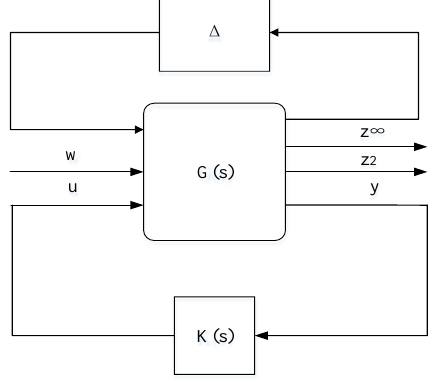
Figure 10. The standard H2/H ∞ design Figure 10. The s tandard H2/H∞ design problem .